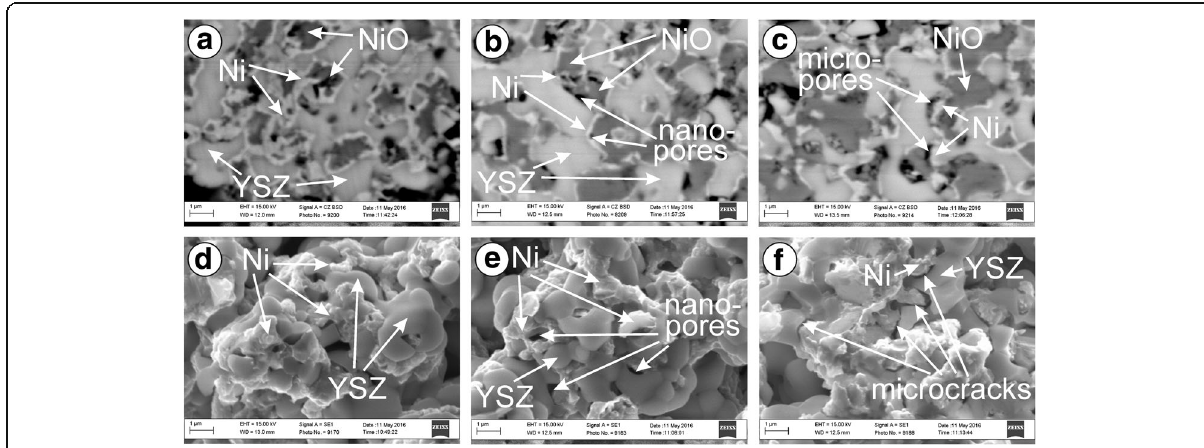
Fig. 4 SEM a – c structure and d – f fractographies of specimens preconditioned by redox for 5 cycles, after a , d mode 1, b , e mode 2, and c , f mode 3 test (see Table